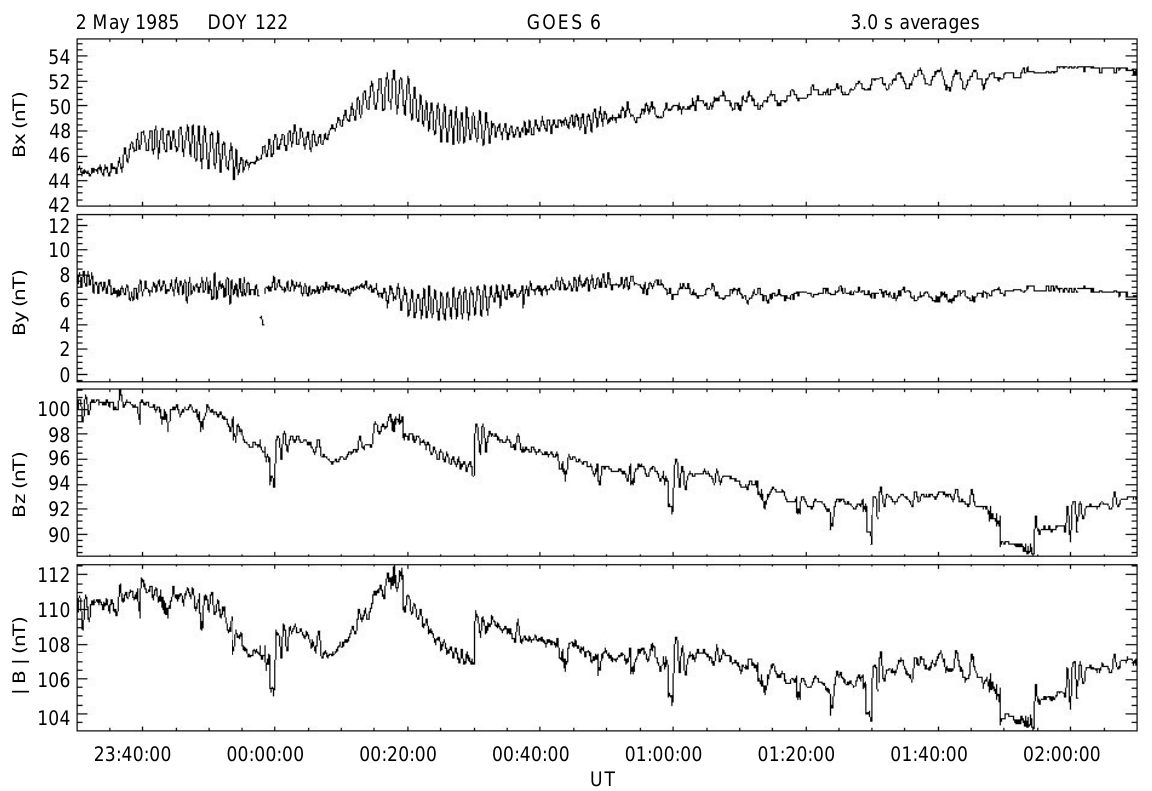
Fig. 1. Time series of the three components and the calculated magnitude of the magnetic field